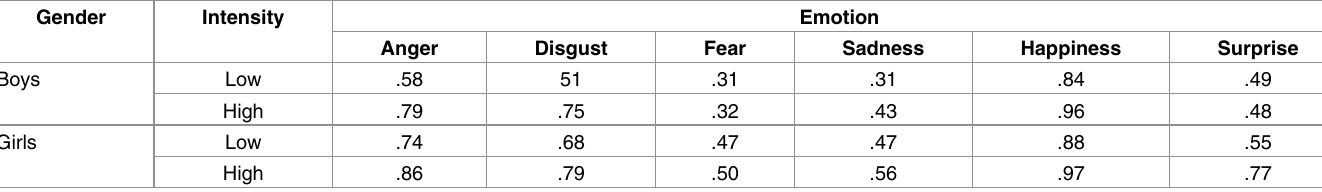
Table 1. Mean proportion of accuracyin emotion recognition by intensity, emotion and gender.